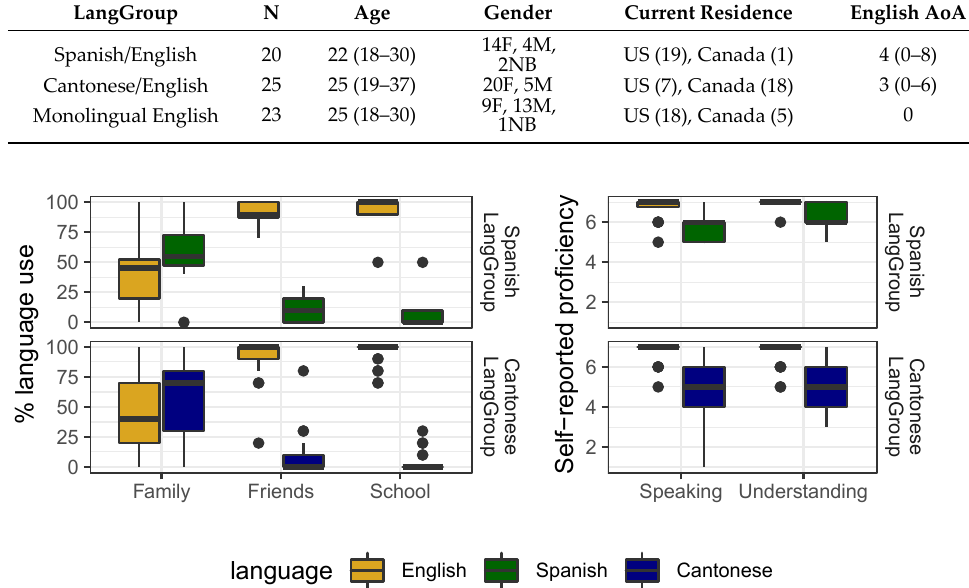
Figure 1. Distribution of self‑reported proficiency, on a scale from 1 to 7, for Spanish/English ( top ) and Cantonese/English ( bottom ) speakers in speaking and understanding English and Spanish or Cantonese ( left ), and percentage use of each language with family, friends, and at school ( right ).